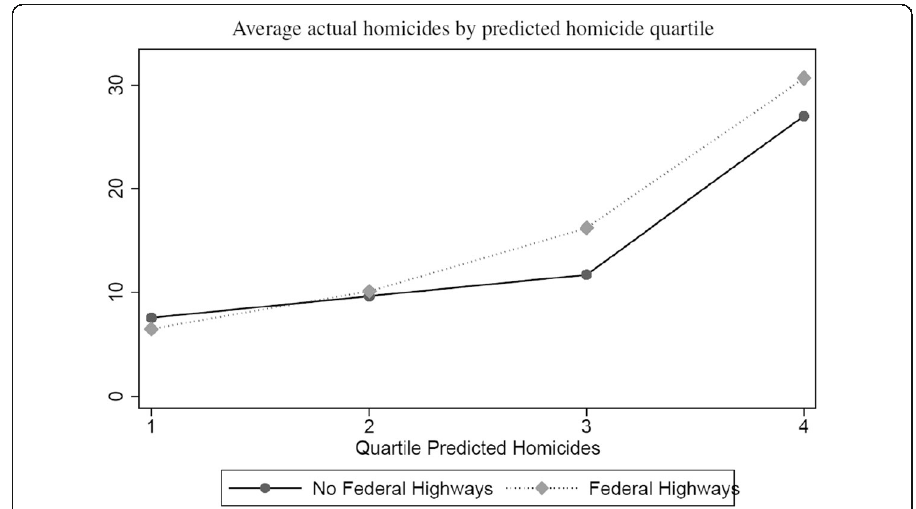
Fig. 2 Test of monotonicity. Quartiles from predicted homicide values without